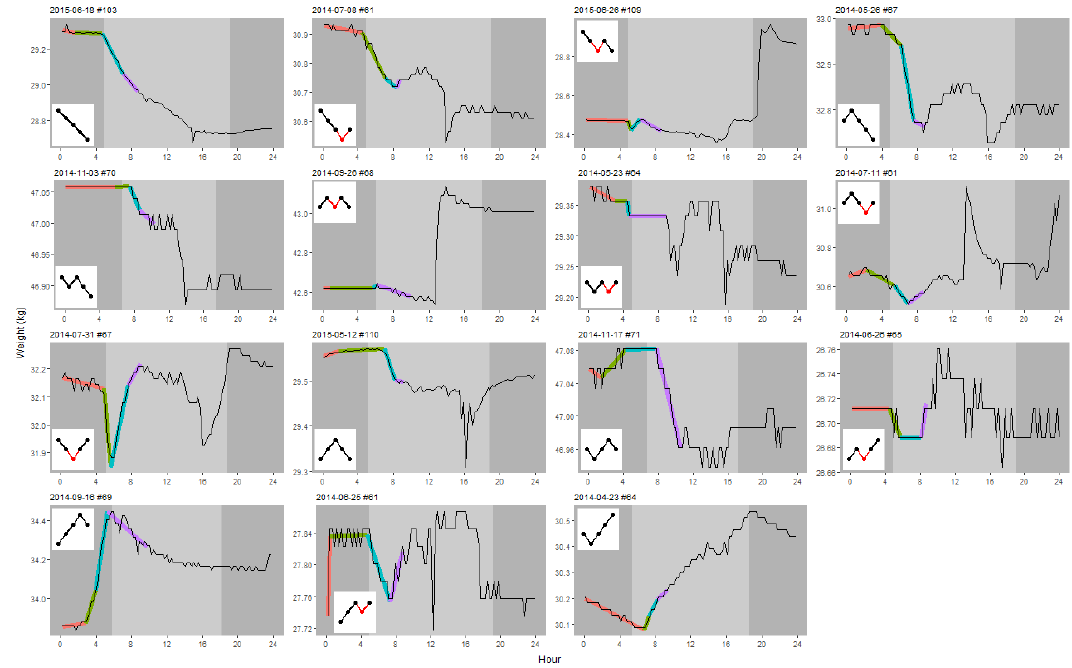
Figure 2. Typical course of the segmented linear regression (SLR) models. For each of the 15 types, the model with the median r 2 value was selected as typical and shown above, identified by date and hive number. The four segments are shown in different colours while the underlying black curve shows the weight during 24 h. Light vs. dark background shows day vs. night. The inset graphical keys refer to Figure 3.